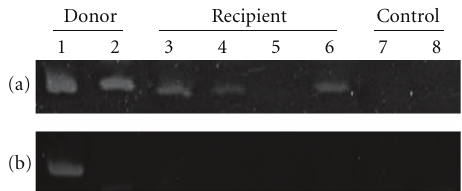
Figure 1: Engraftment of male human and canine umbilical cord MSCs into muscle of female GRMD dogs. Polymerase chain reac- tion analysis for (a) sex-determining region Y (SRY) sequence and (b) canine-specific dystrophin sequence. Muscles samples shown are the following: (1) male cUCV MSC from L3M5; (2) male hUCT MSC; (3, 4) B144 and B312 from a ff ected female L3F1; (5, 6) B144 and B312 from a ff ected female L3F2; (7) female canine control DNA; (8) female human control